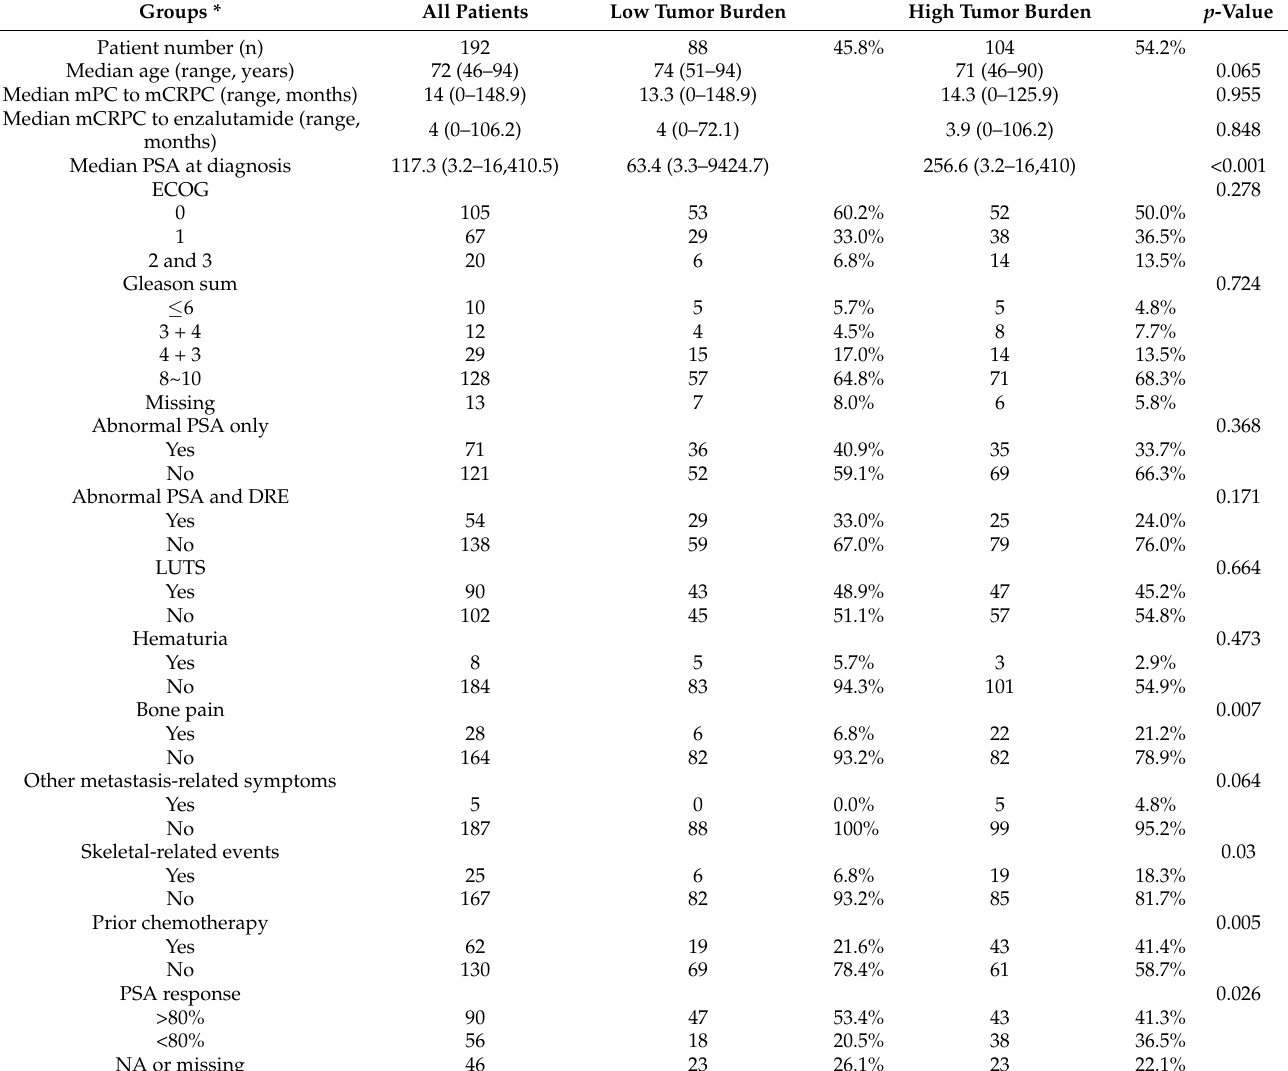
Table 1. Demographics of prostate cancer patients stratified by tumor